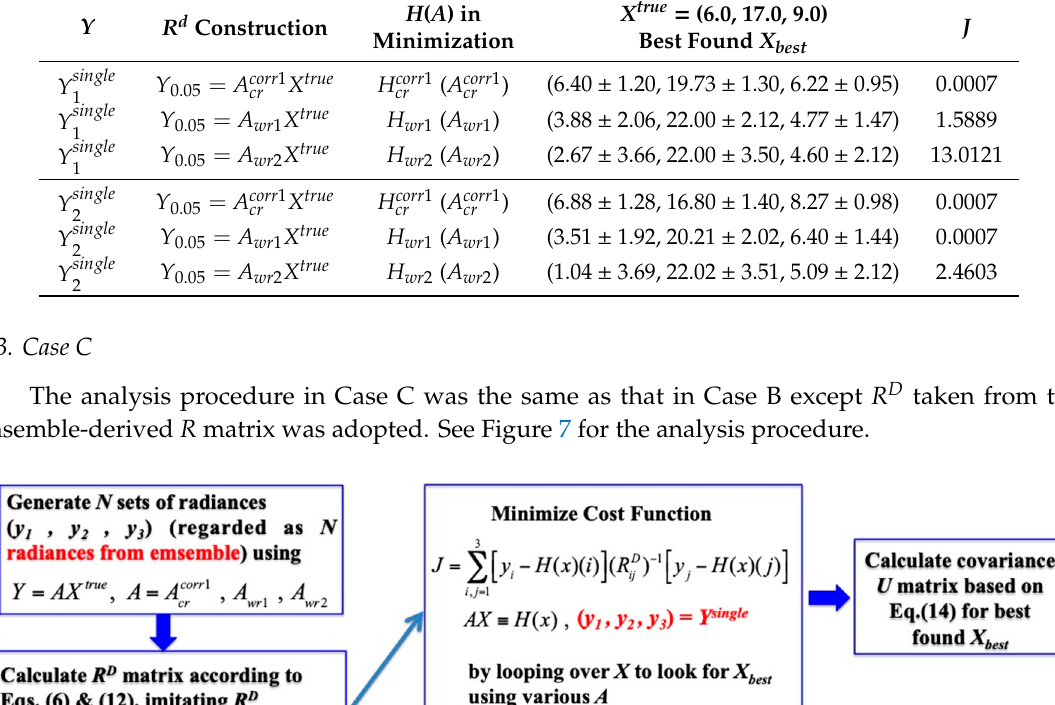
Table 3. Results for Case C, where Y single